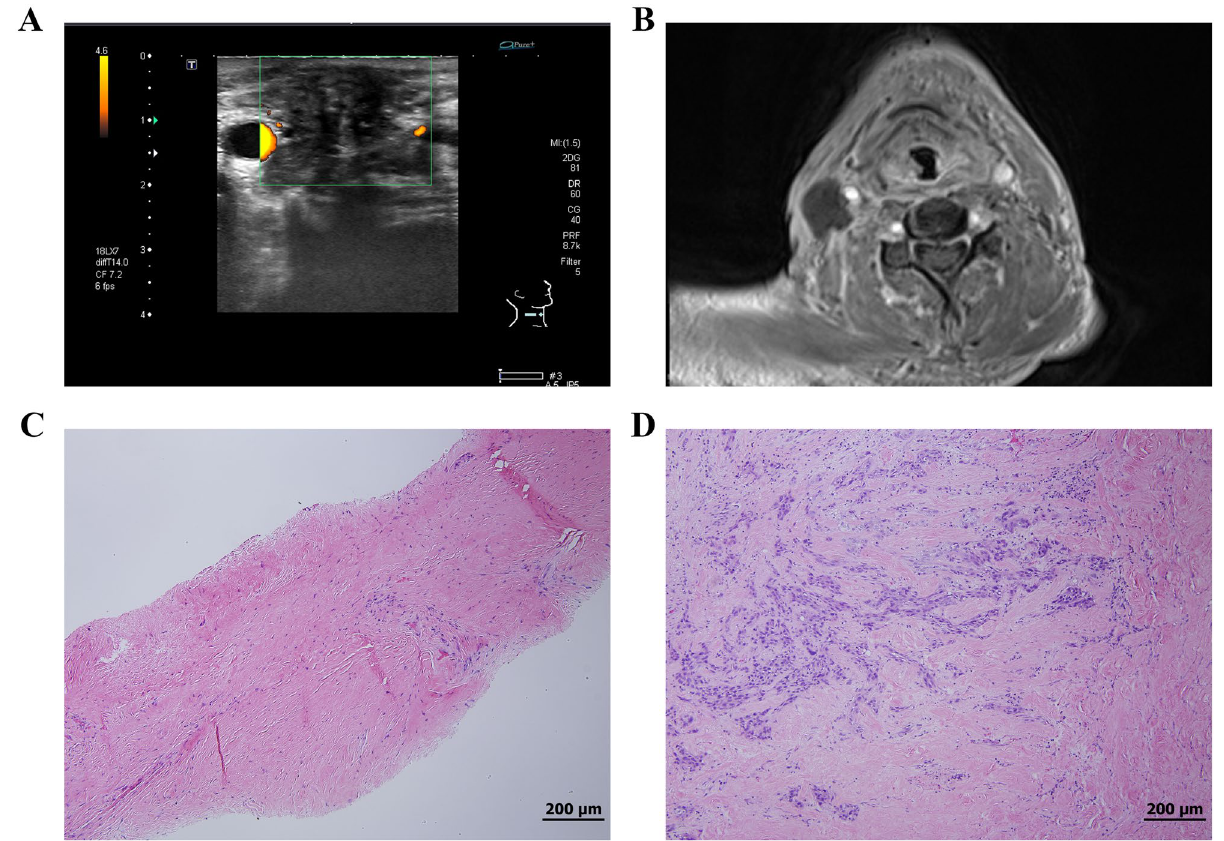
Figure 4. ( A ) Ultrasound picture of treated right tongue cancer with ipsilateral nodal mass; ( B ) corresponding magnetic resonance imaging showing axial view of T1 with gadolinium contrast medium; ( C )